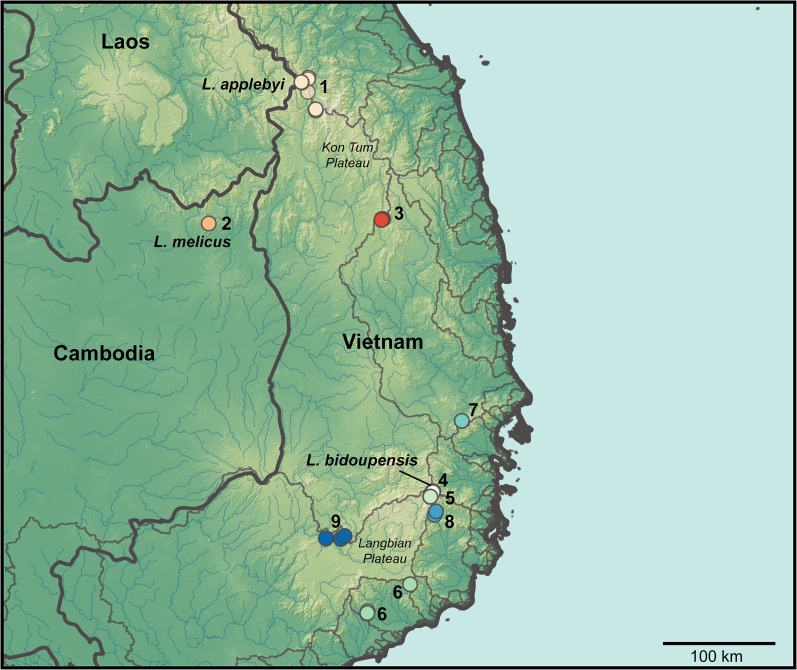
Map showing the localities where specimens in the Leptolalax applebyi group were collected.Colours of localities assigned based on the nine molecular lineages. Paler areas are higher elevation. Dark grey lines show country boundaries, pale grey lines show watershed boundaries and blue lines show rivers.